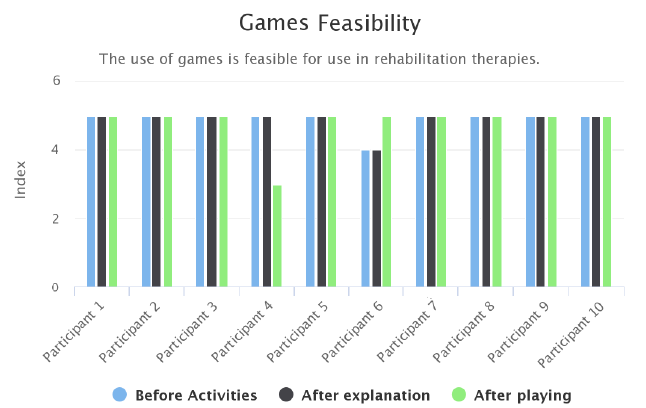
Figure 7: Physiotherapists opinion about the feasibility of using games during therapy processes before and after the experiment ac- tivities